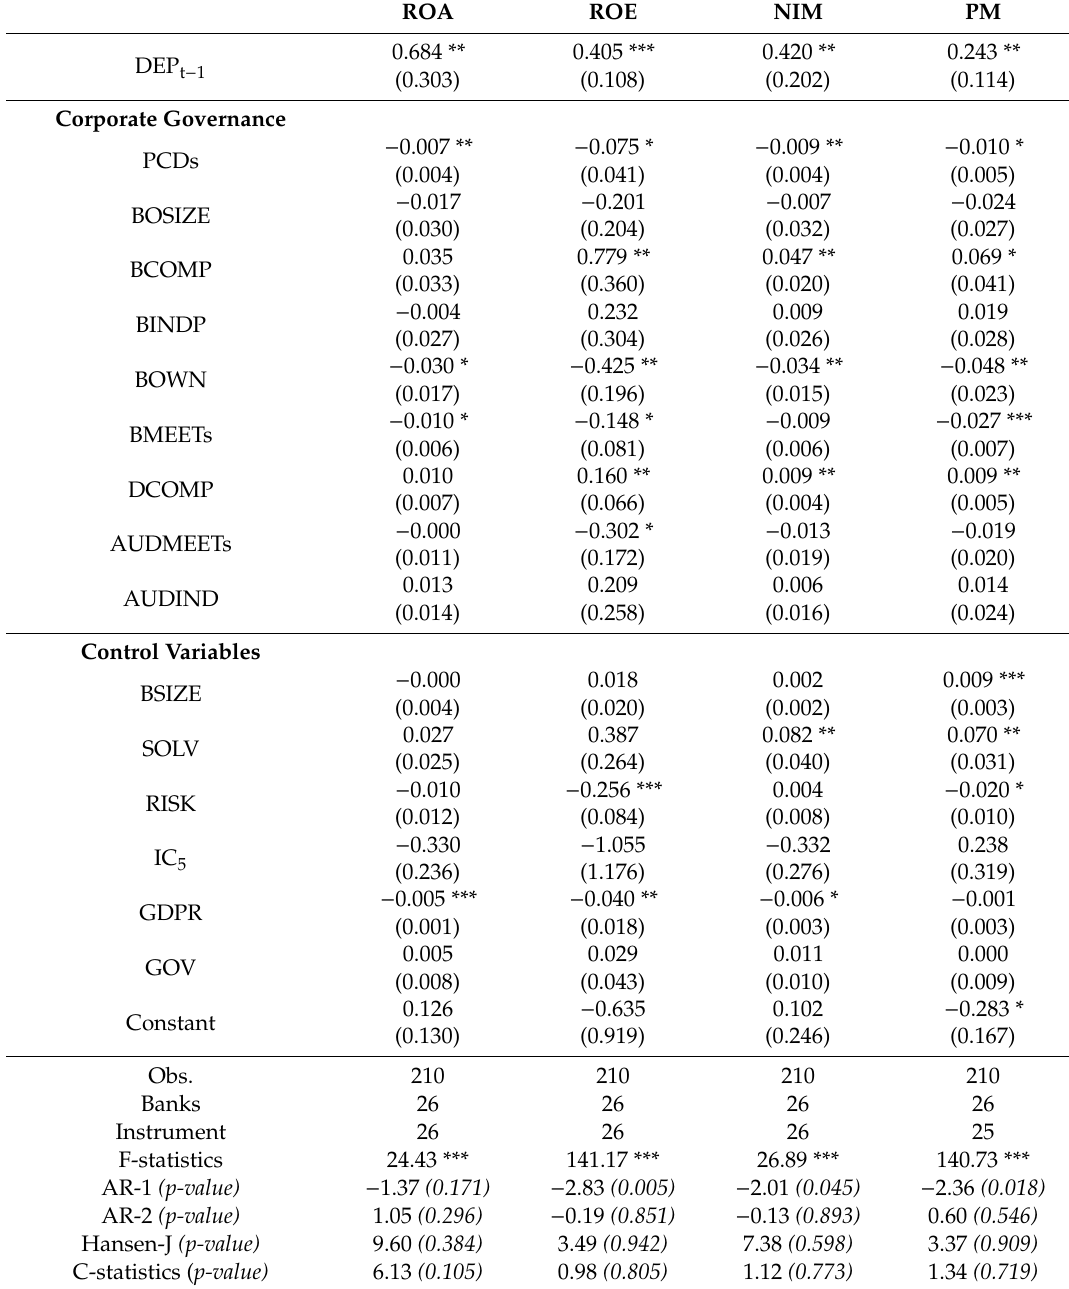
Table 5. Politically connected directors (PCDs) and bank